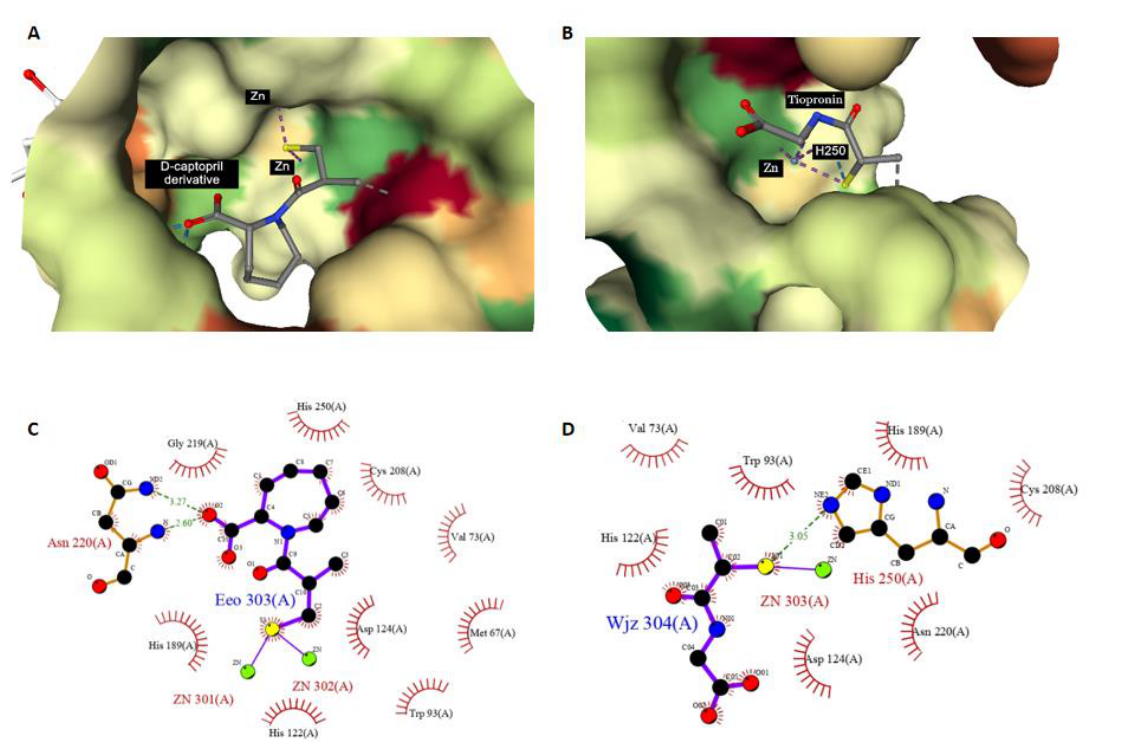
Figure 8: Ligplot illustration of thiol group in ligand/NDM-1 interaction. A and C are the D - captopril de- rivative from PDB 6LIZ, B and D are the tiopronin from PDB